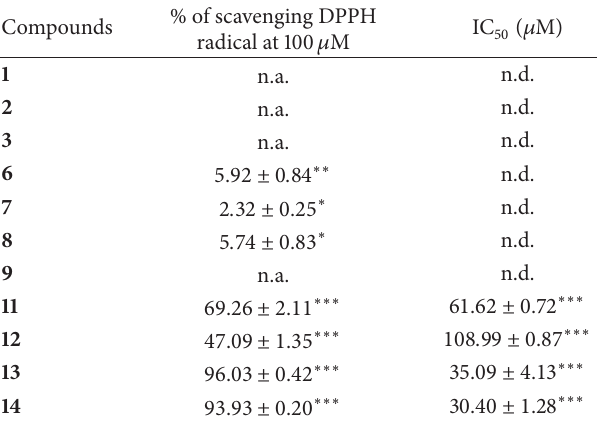
Table 1: DPPH radical scavenging activity of tested compounds. % of scavenging DPPH Compounds radical at 100 𝜇 M